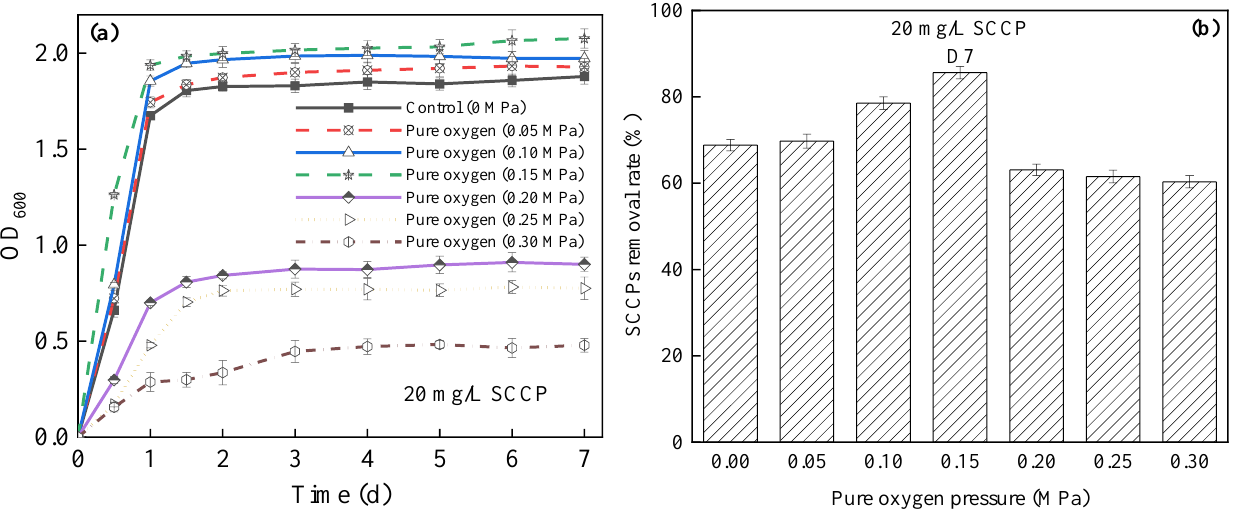
Figure 1. Relationship between different high-purity oxygen pressures and ( a ) the growth of E. coli strain 2; ( b ) SCCP removal rate in a pressurized reactor. SCCPs, short-chain chlorinated paraffins.